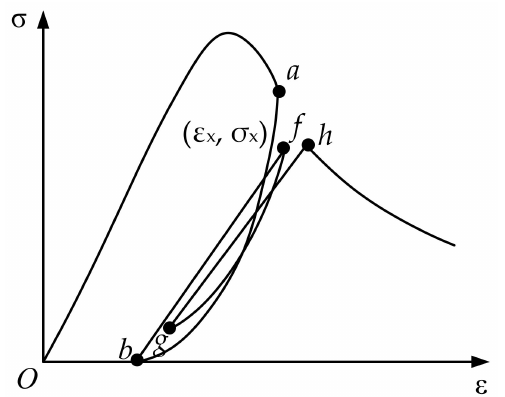
Figure 6. Local unloading of the damage model: the letters a , b , f , g , h are points on the curve of the partial unloading